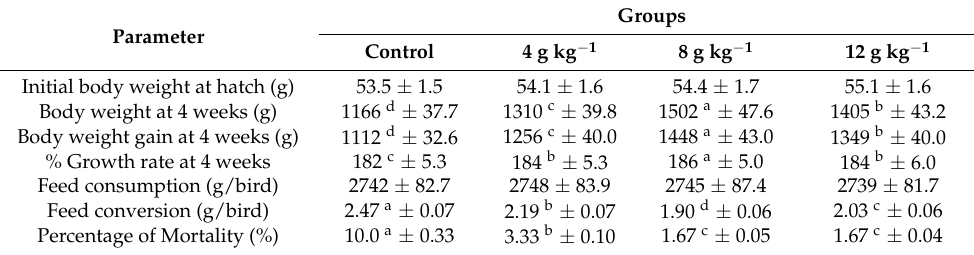
Table 5. Means ± standard errors for growth performance, nutritional parameters, and mortality rate of growing ducks supported by S. marianum dry seeds at different levels (4, 8, and 12 g kg − 1 diet) as well as control during the brooding period.